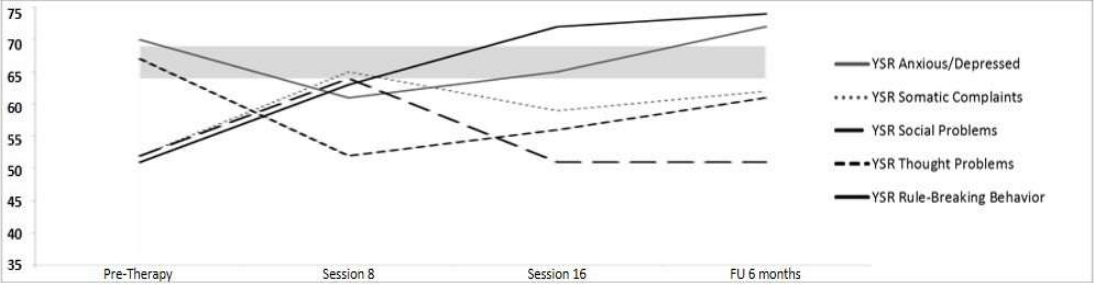
Figure 3: Deborah’s Youth Self Report (YSR) sub-scales T-scores Note . FU = follow-up. YSR = Youth-Self Report (Achenbach, 1991). The grey area indicates the borderline range. Above the grey area scores are considered in the clinical range, below in the normal range.